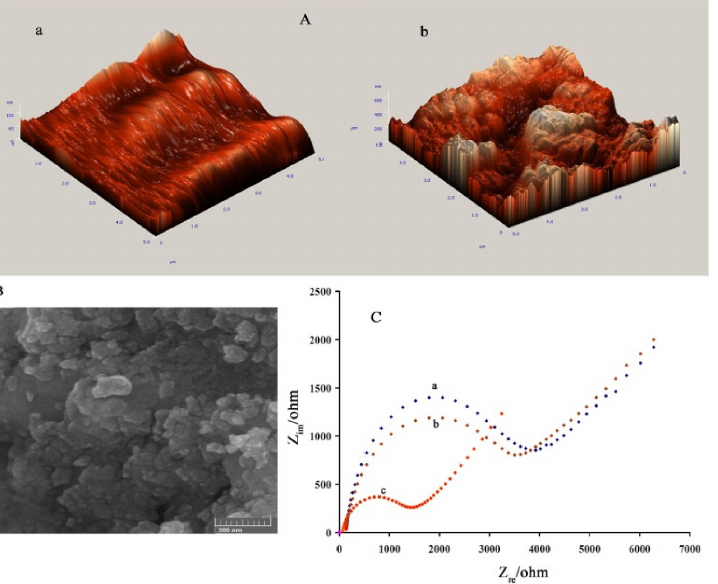
Figure 6. ( A ) AFM images of neat PGE ( a ) and PGE/CuO-NPs/PPy nanocomposite ( b ). ( B ) SEM micrograph of the nanocomposite ( C ) Nyquist plots of neat PGE (a), PGE/PPy (b), and the ternary nanocomposite (c). Reprinted from [65], copyright 2020,